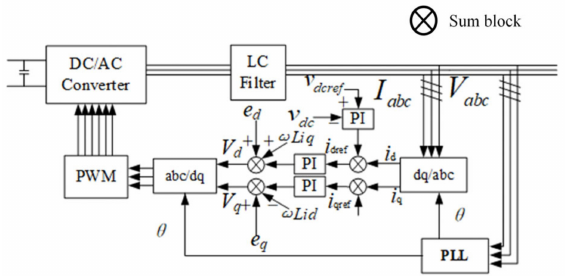
Figure 5. Bidirectional DC–AC converter control block diagram of battery.